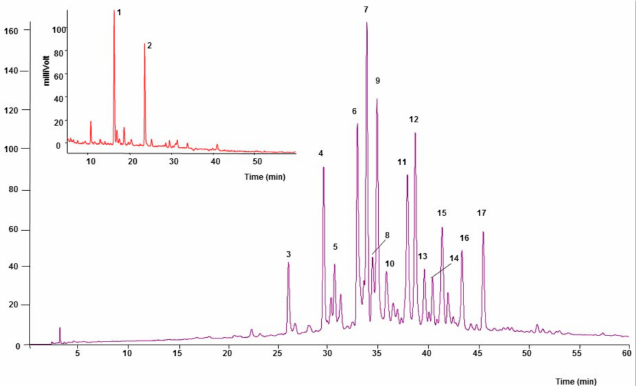
Figure 1. HPLC-ESI/MS profile of F. deltoidea aqueous extract (FDAE), analyzed by gradient phase at 365 nm (purple) and florescence detector (red). Table 1. Tentative identification of phenolic compounds in F. deltoidea extract determined by HPLC-ESI.